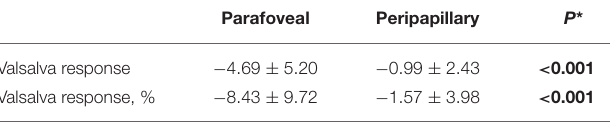
TABLE 3 | Difference in Valsalva maneuver response between the parafoveal and peripapillary regions.